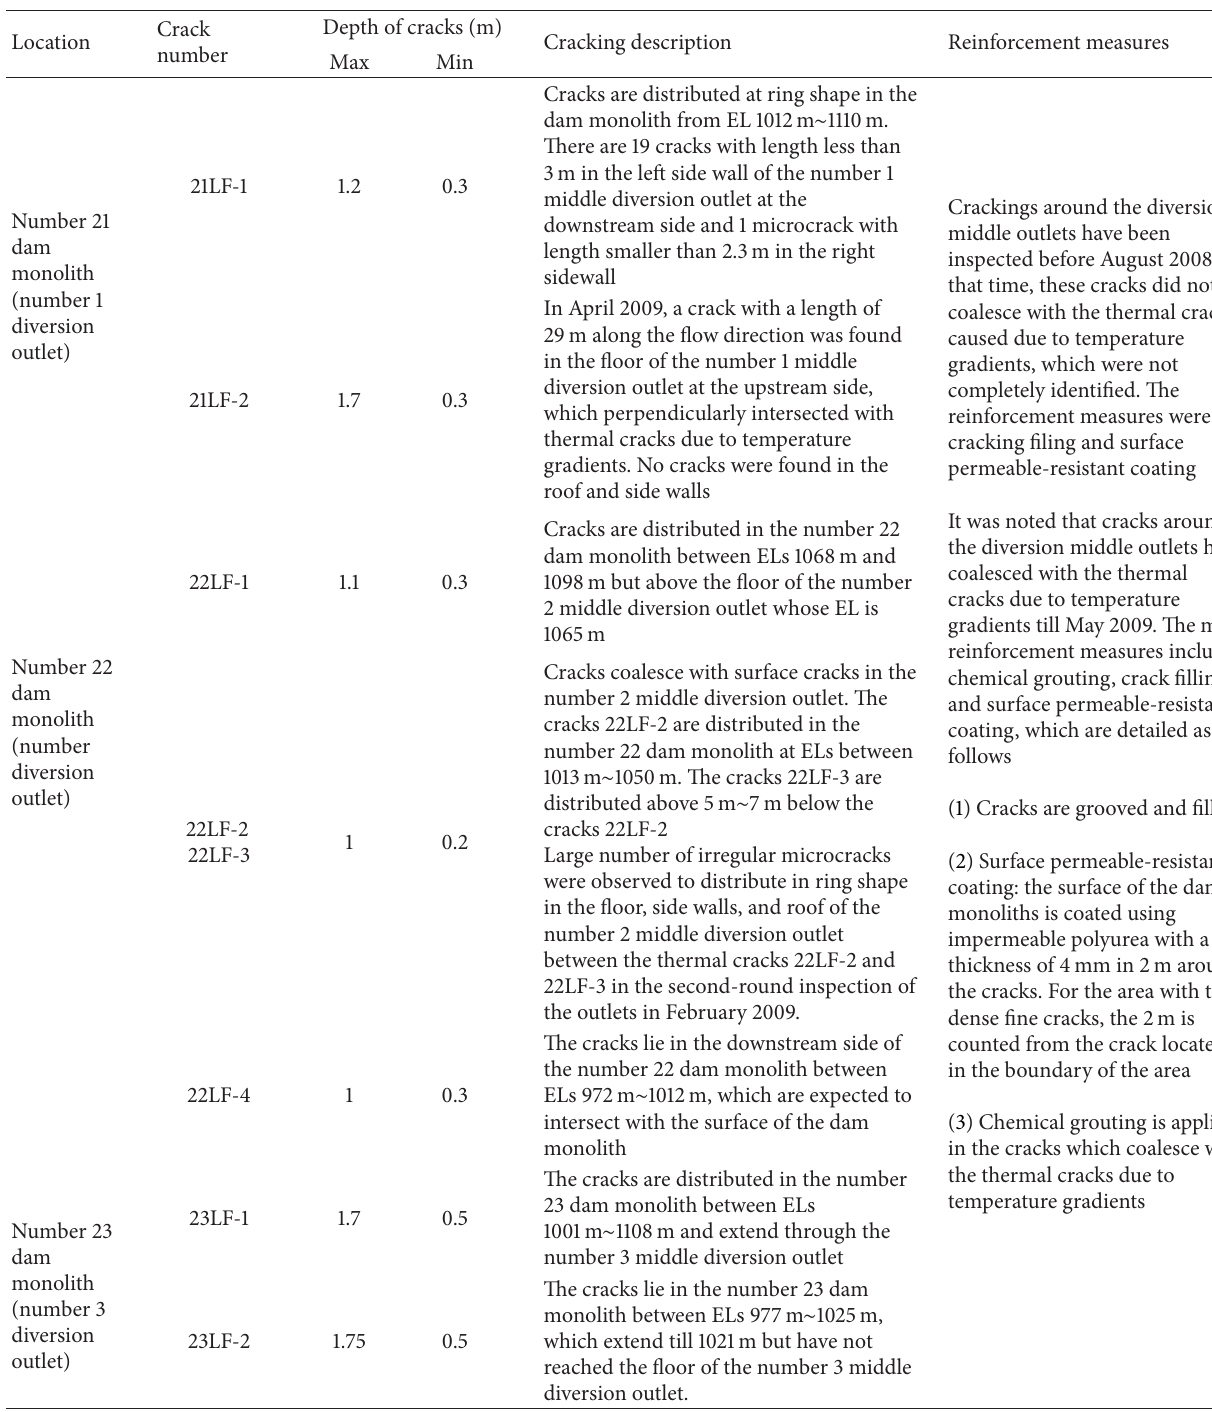
Table 2: Cracking characteristics and reinforcement measures of the middle outlets in the Xiaowan arch